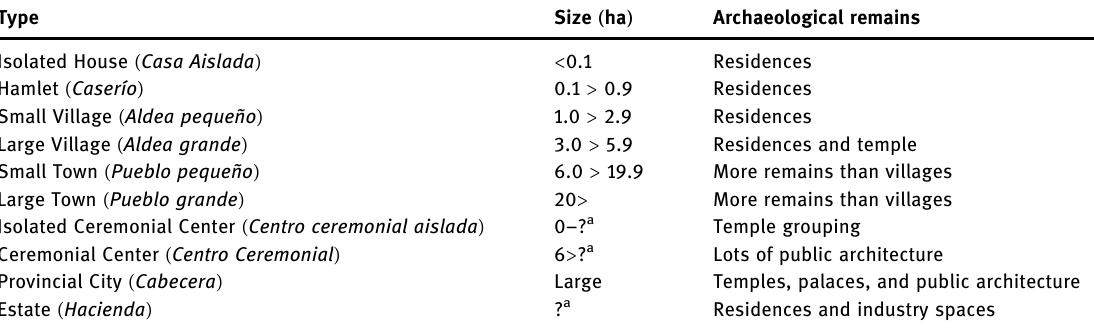
Table 2: Typology of sites Type Size ( ha